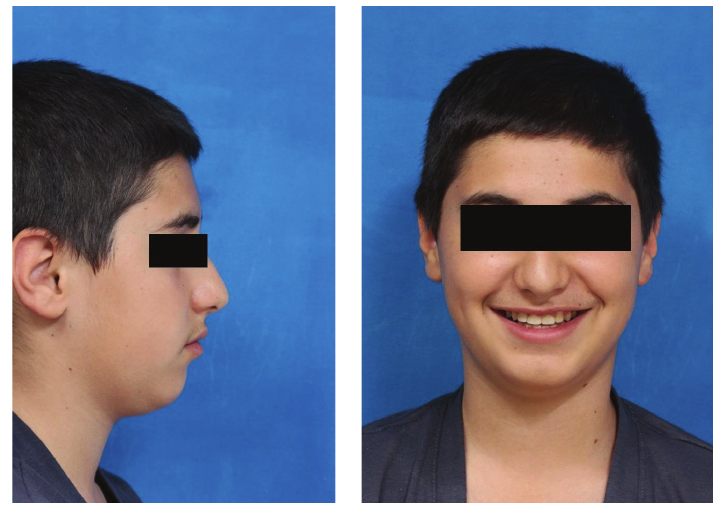
Figure 4: Posttreatment facial photography.